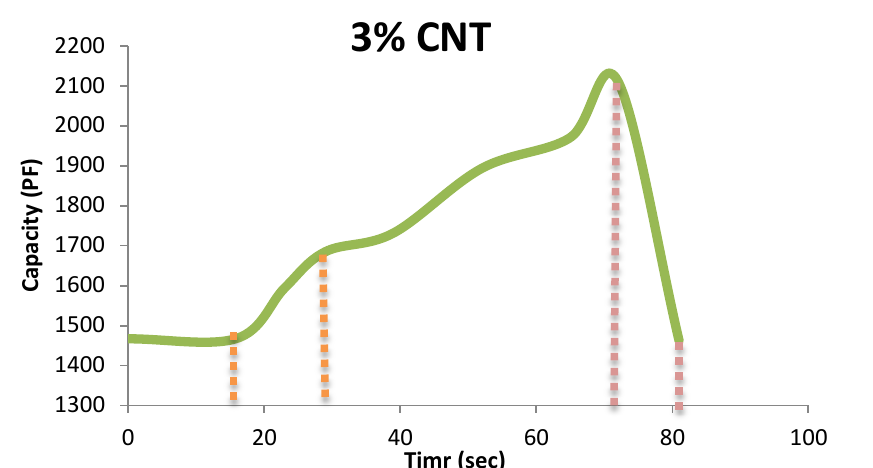
Fig.12: Response time and recovery time for humidity sensor with 3wt% MWCNT.